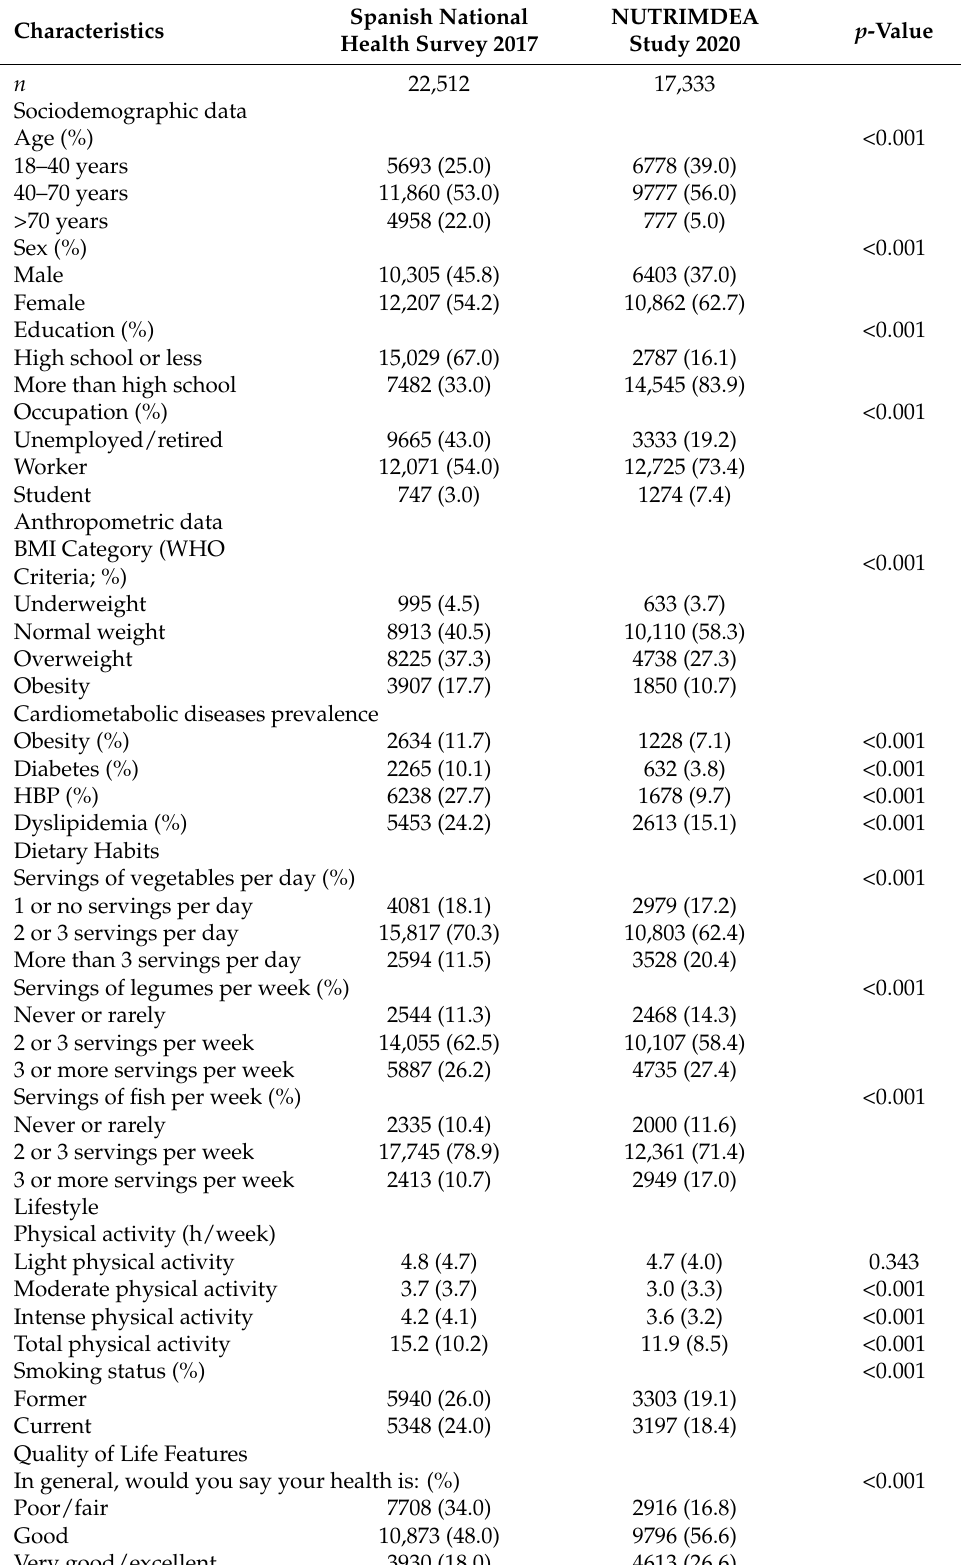
Table 1. Sociodemographic Data, Health Characteristics, Dietary Habits, Lifestyle and Quality of Life Features Categorized by Spanish National Health Survey 2017 and NUTRIMDEA Study